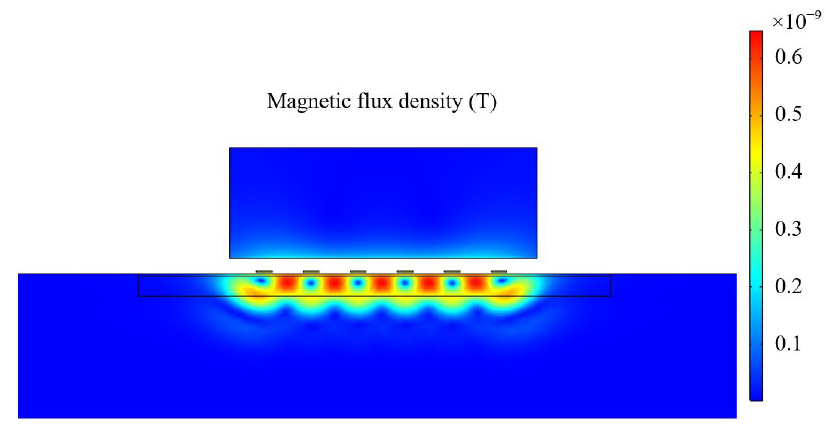
Figure 10. Magnetic flux density distribution of the excitation coil. Figure s 11 and 12 show the bias magnetic field and eddy current field of the EMAT.